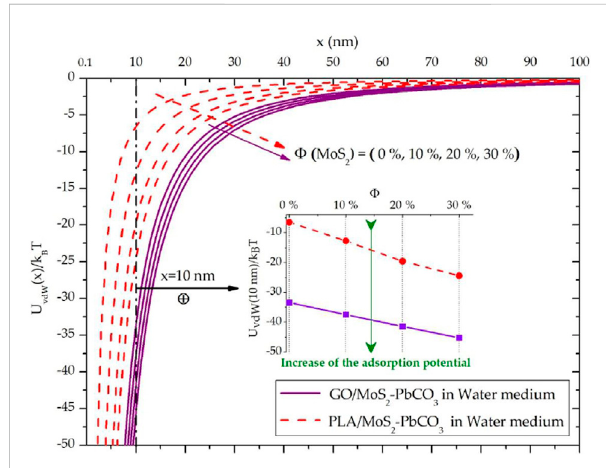
FIGURE 3 Effect of the fi lling rates with MoS 2 NPs on the evolution of the vdW adsorption potential between Cerussite “ PbCO 3 ” adsorbate and